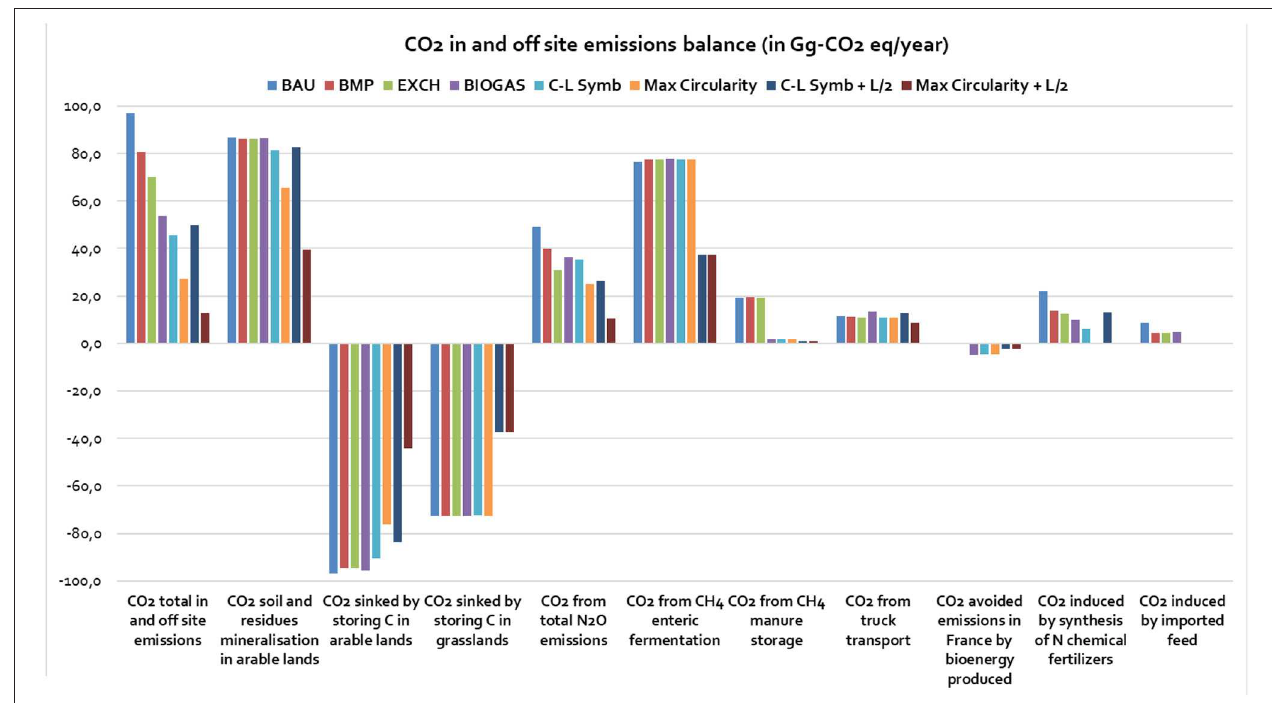
FIGURE 7 | Emissions from on- and off-site emissions (positive) and C stored expressed as CO 2 avoided (negative), from FAN scenario outputs (in kg of CO 2 -equivalence per year). Scenarios names are in Figure 3 and Table 2